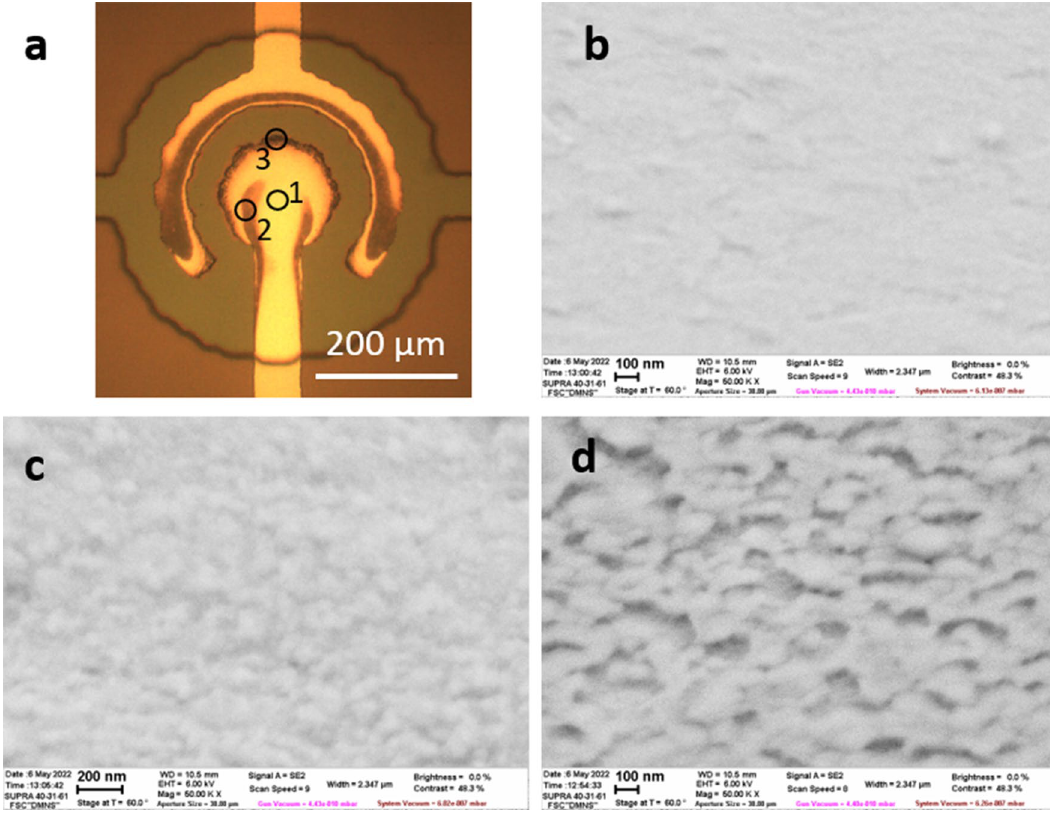
Figure 6. Electrodes after the test with the driving frequency f = 100 kHz. ( a ) Optical image of the electrodes after 4 h test at f c = 10 Hz, U = 8.1 V. The black circles mark the areas investigated with SEM. ( b – d ) SEM ◦ images taken in the areas 1, 2, and 3, respectively. The stage angle is 60